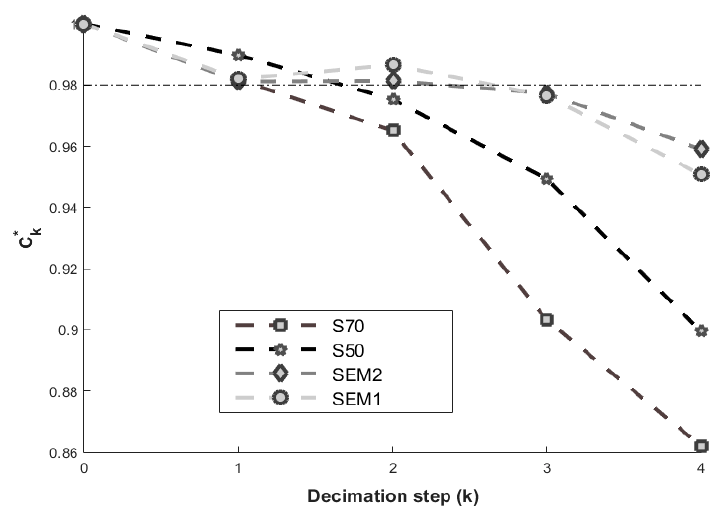
Figure 5. Normalized Coarseness for the first 5 values of the decimation process ( k ) applied to S70, S50, SEM1, and SEM2 figures.